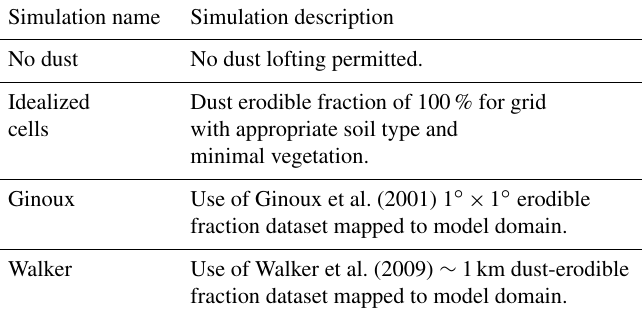
Table 3. Summary of